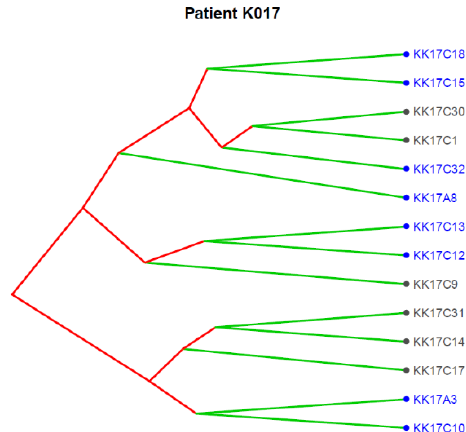
Figure 4. Translational oncology (TRONCO) was used to order 14 single CTCs isolated from patient K017 into a clonal hierarchy. The figure represents phylogenies of single CTCs grouped into three distinct clones by considering genomic regions altered in at least 50% of all CTCs. Loss at 9p21.3 (indicated by blue color) was observed across all the three